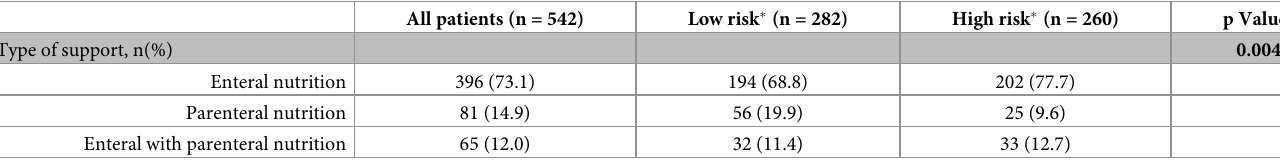
Table 2. Nutritional support provided to included patients and stratified by NUTRIC